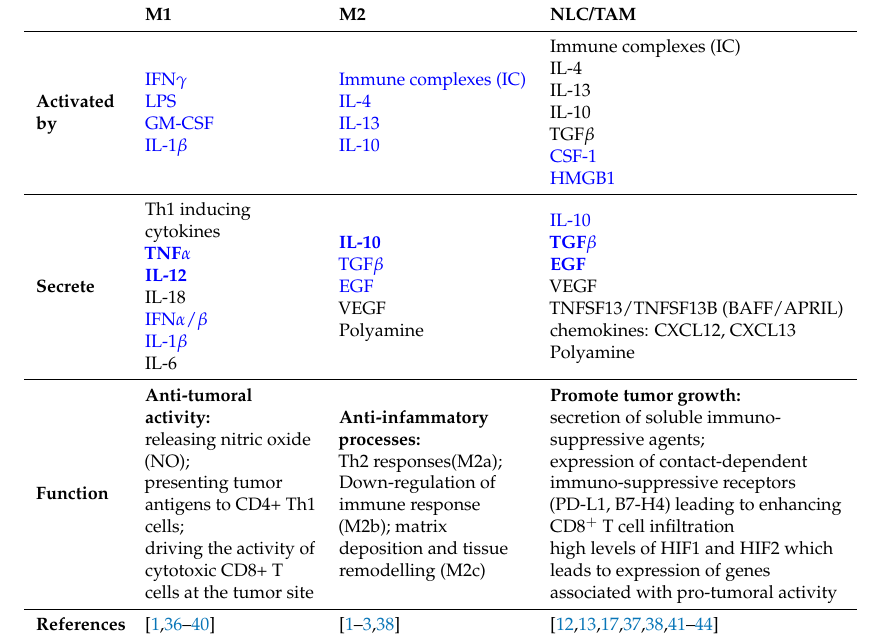
Table 1. The main characteristics of M1, M2 and NLC/TAM phenotypes according to (i) activators, (ii) secreted cytokines or expressed genes, and (iii) functions in tumoral environments (see Appendix A). In blue we indicate the components used in our polarization network and in bold the components used for the signature for each